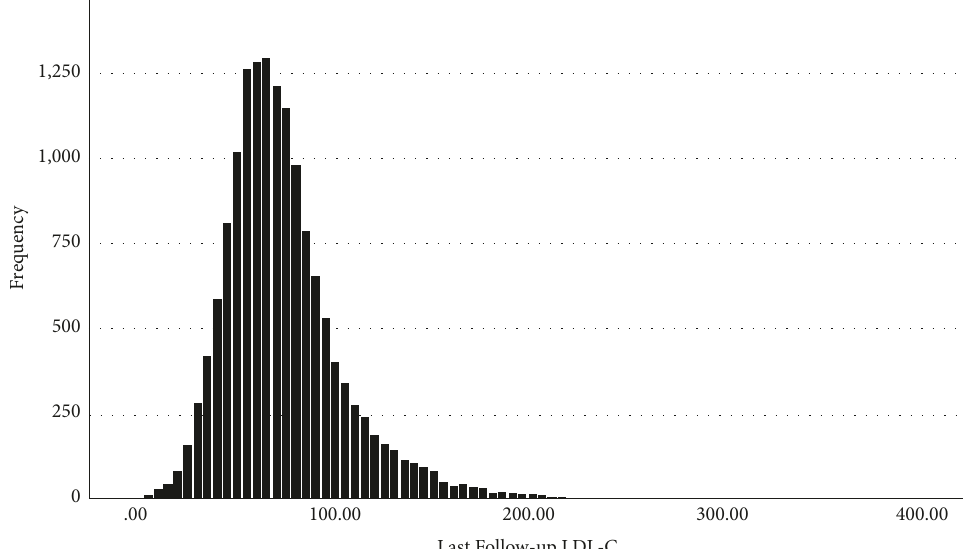
Figure 1: Distribution of final follow-up low-density lipoprotein cholesterol mg/dL levels for 15,111 health system patients with documented coronary artery